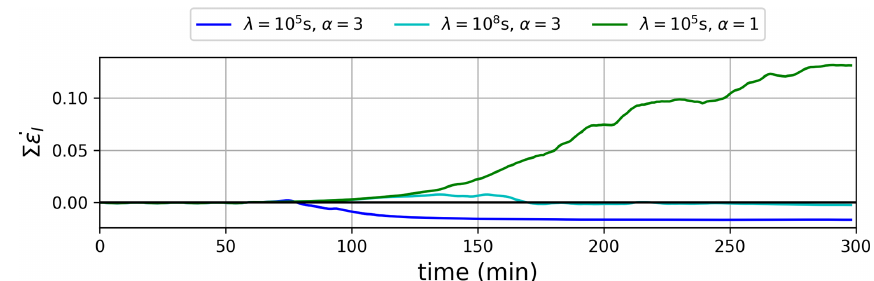
Figure 12. Time evolution of the mean normal strain rate invariant integrated over the ice cover (d − 1 ) using a stress correction path normal to the yield curve ( γ = arctan (µ) ) with α = 3 (blue), α = 1 and a longer viscous dissipation timescale ( λ = 10 8